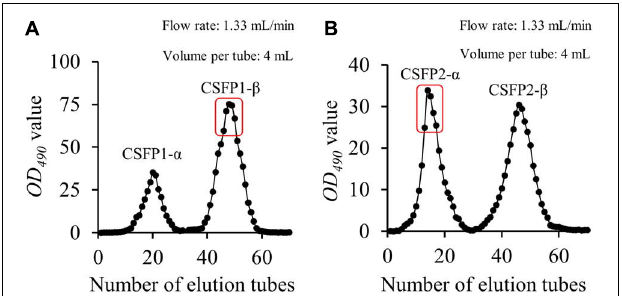
FIGURE 1 | Elution profiles of CSFP in Sephacryl S-400. The sample of CSFP is loaded into the DEAE-52 anion exchange column. The collected component was named as CSFP1 after washing with ultrapure water, and then the collected component was named as CSFP2 after adding 0.1 M NaCl solution. (A) Elution profiles of CSFP1 in Sephacryl S-400 of the, and (B) Elution profiles of CSFP2 in Sephacryl S-400.